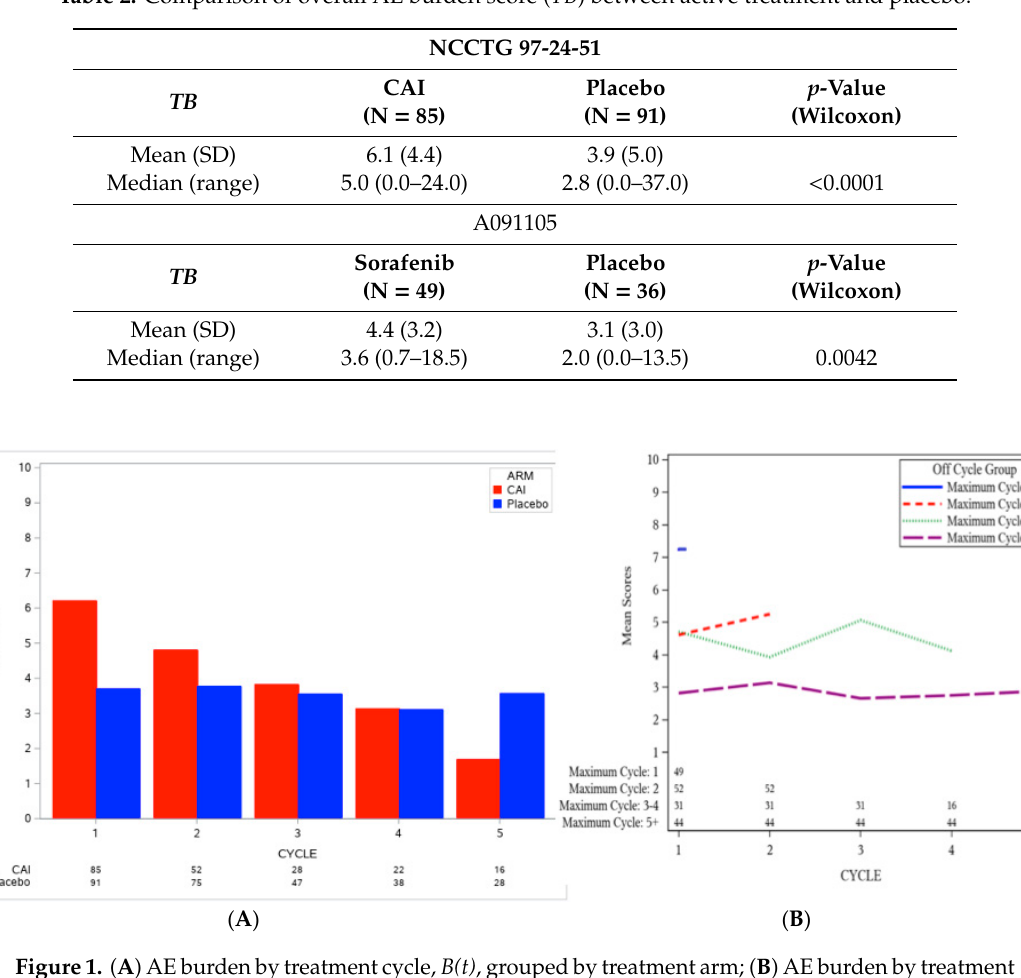
Table 2. Comparison of overall AE burden score ( TB ) between active treatment and placebo.